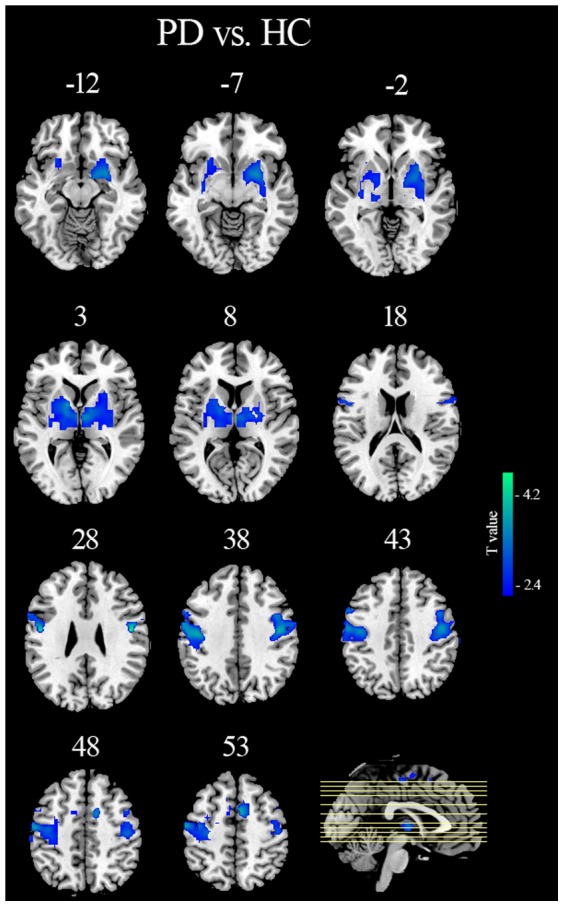
Brain regions with blue color indicated significant (FDR multiple comparison correction, p<0.05) decreases of efficiency map in PD relative to healthy control using two-tailed two sample t test with age, gender and frame-wise displacement as covariance.Those regions were presented in axial view. HC, healthy control; PD, Parkinson's disease.